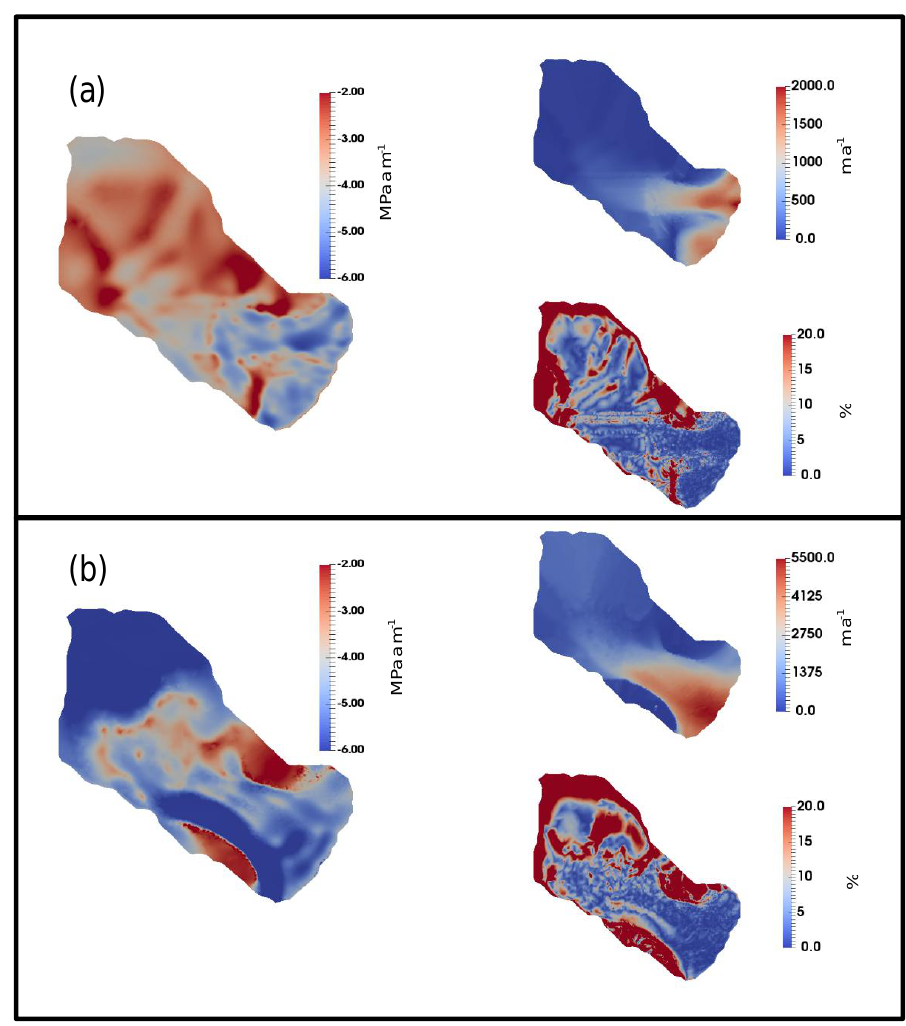
Figure 2. Basal friction coefficient inverted from surface velocity data in (a) 18–29 August 2012 ( C pre ) and (b) 16–27 August 2013 ( C post ) . Both panels display a basal friction coefficient shown on the left, surface velocity data after post-processing (Sect. 2.2) shown on the upper right and the relative difference between observed and modelled surface velocity magnitude shown on the lower